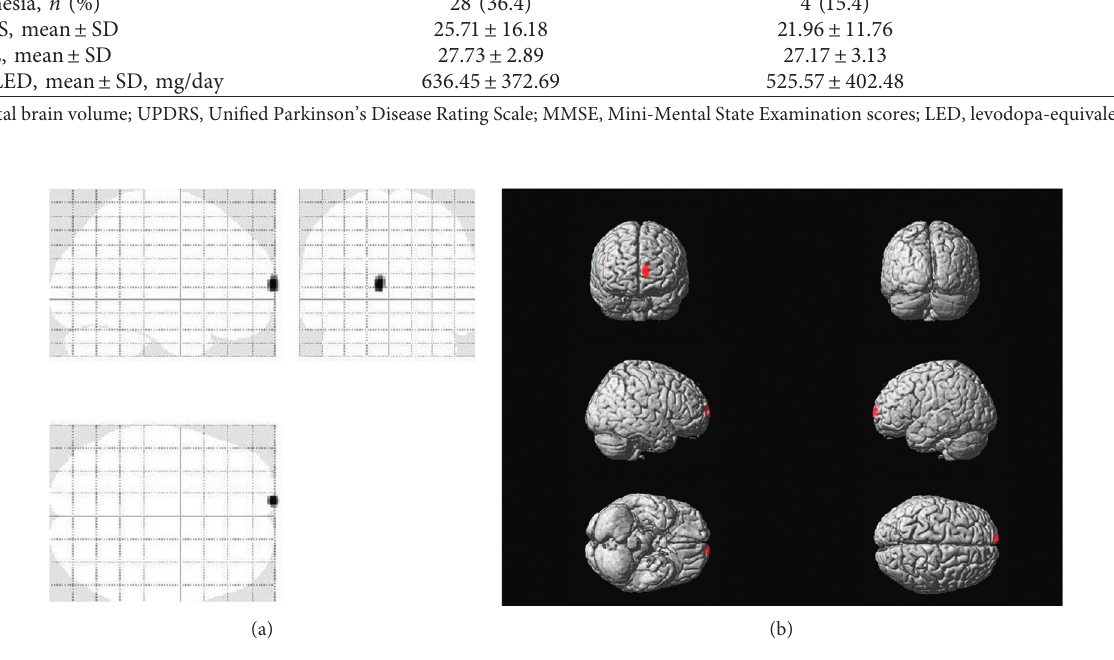
Figure 1: Morphological changes underlying Taq1A polymorphism. The VBM results of 2-dimensional rendering (a) and 3-dimensional (b) overlaid views. The volumes of the left prefrontal lobe were significantly smaller in A2 homo carriers than in A1